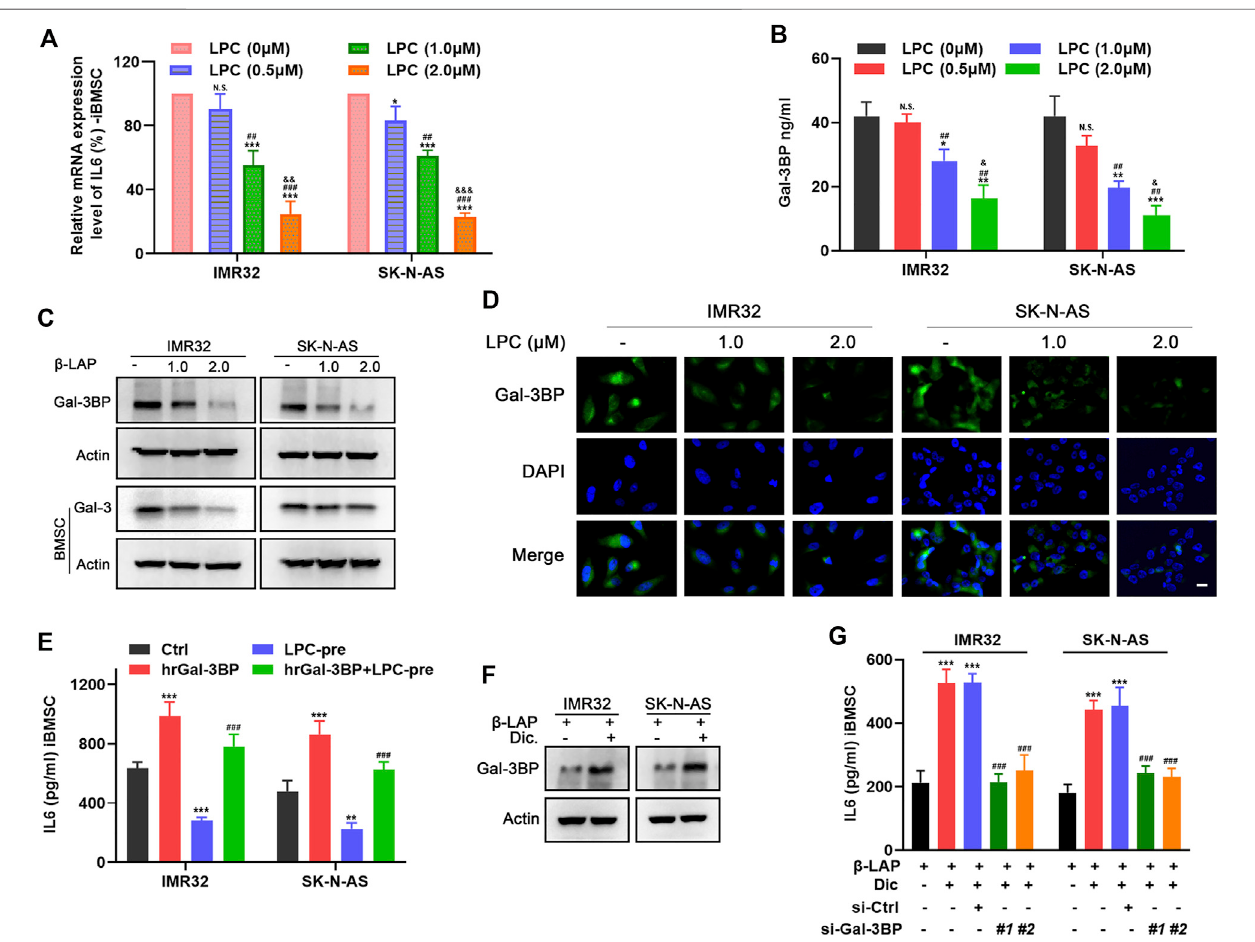
FIGURE 6 | LPC suppresses iBMSC-derived IL6 production through inhibiting Gal-3/Gal-3BP signal in NQO1-dependent manner. LPC-CM obtained from NB cells treated with indicated doses of LPC was used for iBMSC culture. (A) The relative mRNA level of IL6 in iBMSC was detected by qPCR. (B) Gal-3BP secretion from NB cells CM was detected by ELISA. [ *p < 0.05, **p < 0.01 and ***p < 0.001 vs. LPC (0 μ M); #p < 0.01, ##p < 0.01 and ###p < 0.001 vs. LPC (0.5 μ M); & p < 0.05, && p < 0.01 and &&& p < 0.0001 vs. LPC (1.0 μ M)] (C) The relative protein expression levels of Gal-3BP in NB cells and Gal-3 in iBMSC were detected by westernblot. (D) TheexpressionandlocalizationofGal-3BPinNBcellsweredetectedbyIF. (E) iBMSCwasculturedwithLPC-CMsupplementedwithorwithouthrGal- 3BP, and the IL6 secretion was detected by ELISA. NB cells were pretreated with or without dicoumarin before LPC stimulation, and their CM was used to stimulate iBMSC. (F) The protein expression levels of Gal-3BP in NB cells were detected by western blot. ( **p < 0.01 and ***p < 0.001 vs ctrl; ###p < 0.001 vs LPC) (G) NB cells transfectedwithGal-3BPsiRNAorcontrolsiRNAweretreatedasshownin Figure6G ,andIL6secretionintheiBMSCCMwasdetectedbyELISA.( ***p < 0.001vs.LPC; ###p < 0.001 vs. LPC + Dic) Data represents three independent